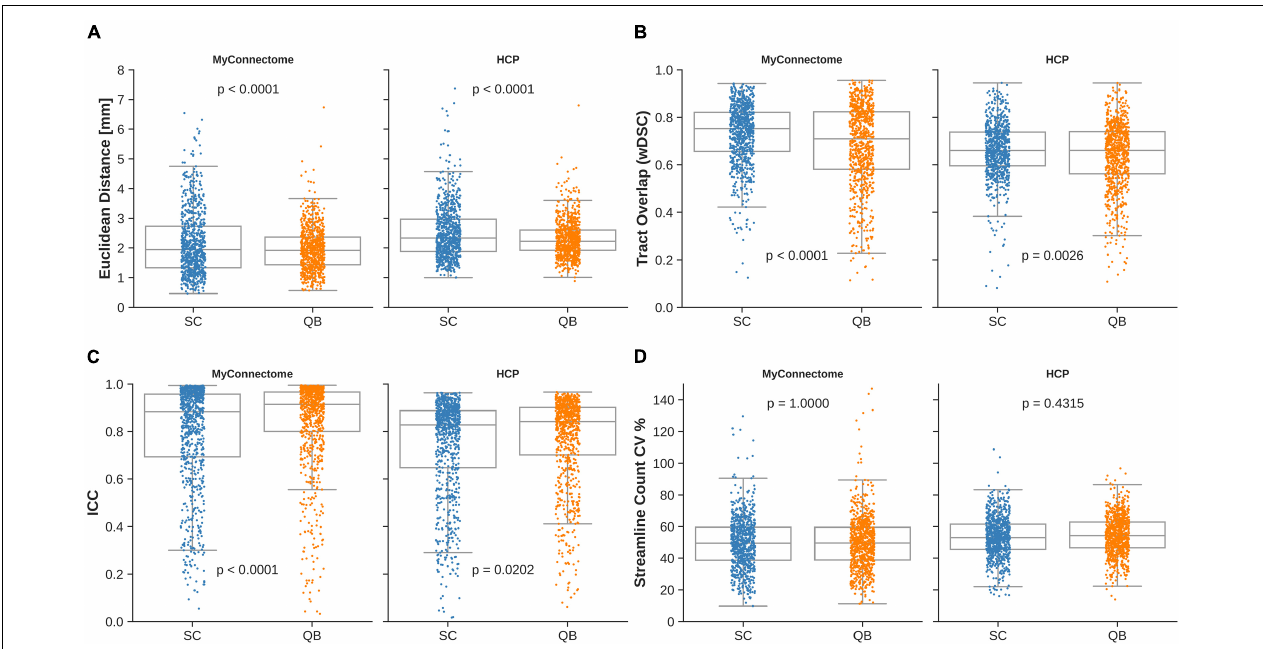
FIGURE 2 | Individual observations for a given metric are overlaid on a box plot for each dataset and clustering method employed by the template. (A) Mean Euclidean distance of tracts relative to the corresponding average tract centroid. (B) Average voxel-wise spatial overlap across corresponding tracts. (C) Along-tract absolute agreement of fractional anisotropy across corresponding tracts. (D) Variability of streamline counts across corresponding